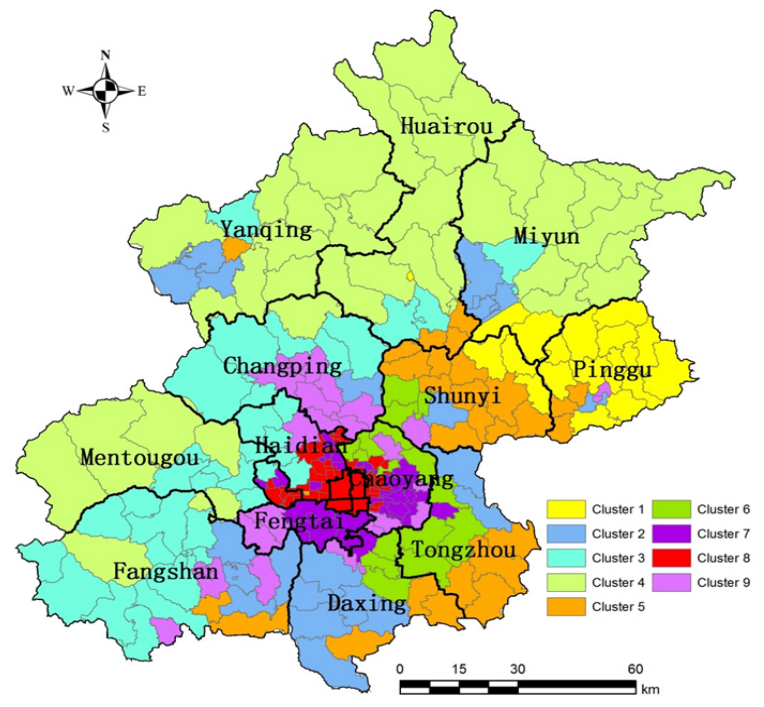
Figure 7. Spatial distribution of the clustering results in Beijing.